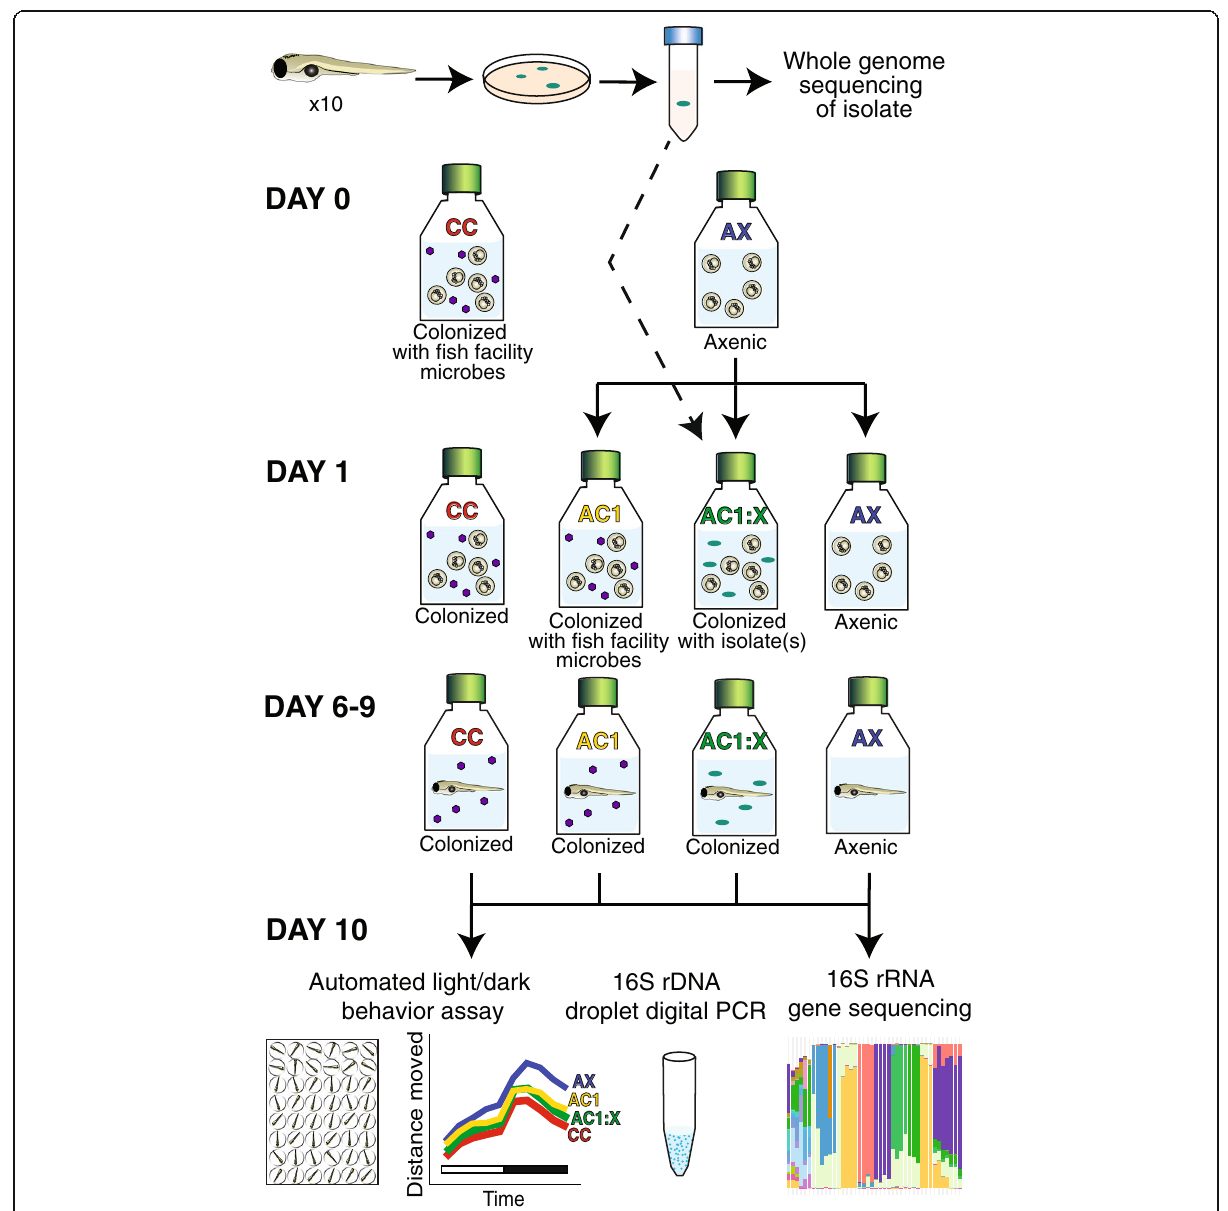
Fig. 1 A zebrafish experimental system with different colonization statuses. To generate host-associated bacterial isolates, visually pure isolates were grown from homogenized zebrafish larvae and then underwent whole genome sequencing. To examine the effects of colonization status on behavior, larvae were generated to be conventionally colonized (CC), axenic (AX), or axenic colonized on day 1 with either aquaculture facility microbes (AC1) or isolated single or mixed bacterial species (AC1:X). At 10 days post-fertilization, larvae were assayed for behavior, bacterial identity (i.e.16S rRNA gene sequencing), and bacterial concentration (i.e. 16S rDNA droplet digital PCR). Purple hexagons indicate heterogeneous aquaculture facility microbes. Turquoise ovals indicate strains of microbes isolated from zebrafish used for association